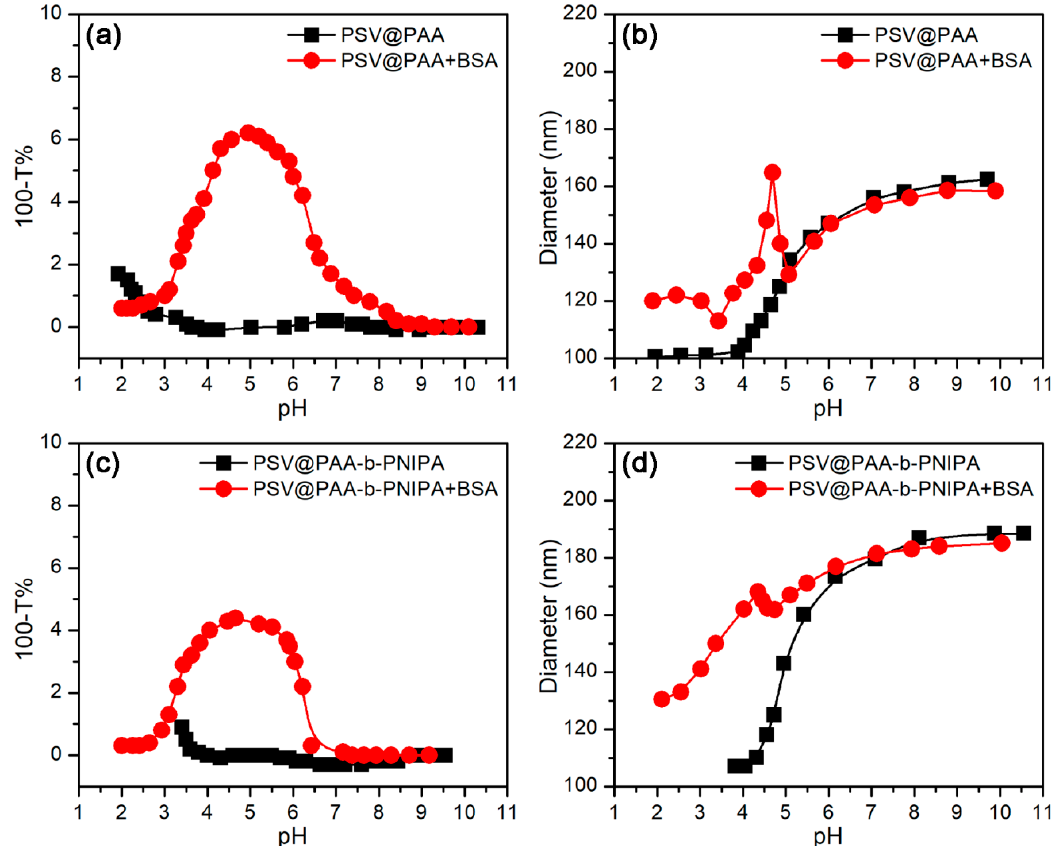
Figure 6. Effect of pH on protein adsorption in PSV@PAA and PSV@PAA- b -PNIPA via ( a , c ) turbidity and ( b , d ) hydrodynamic diameter change.